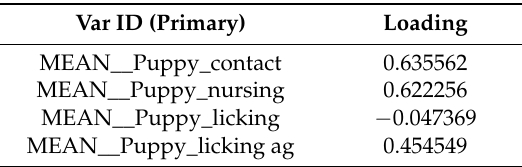
Table 2. Loadings of the principal